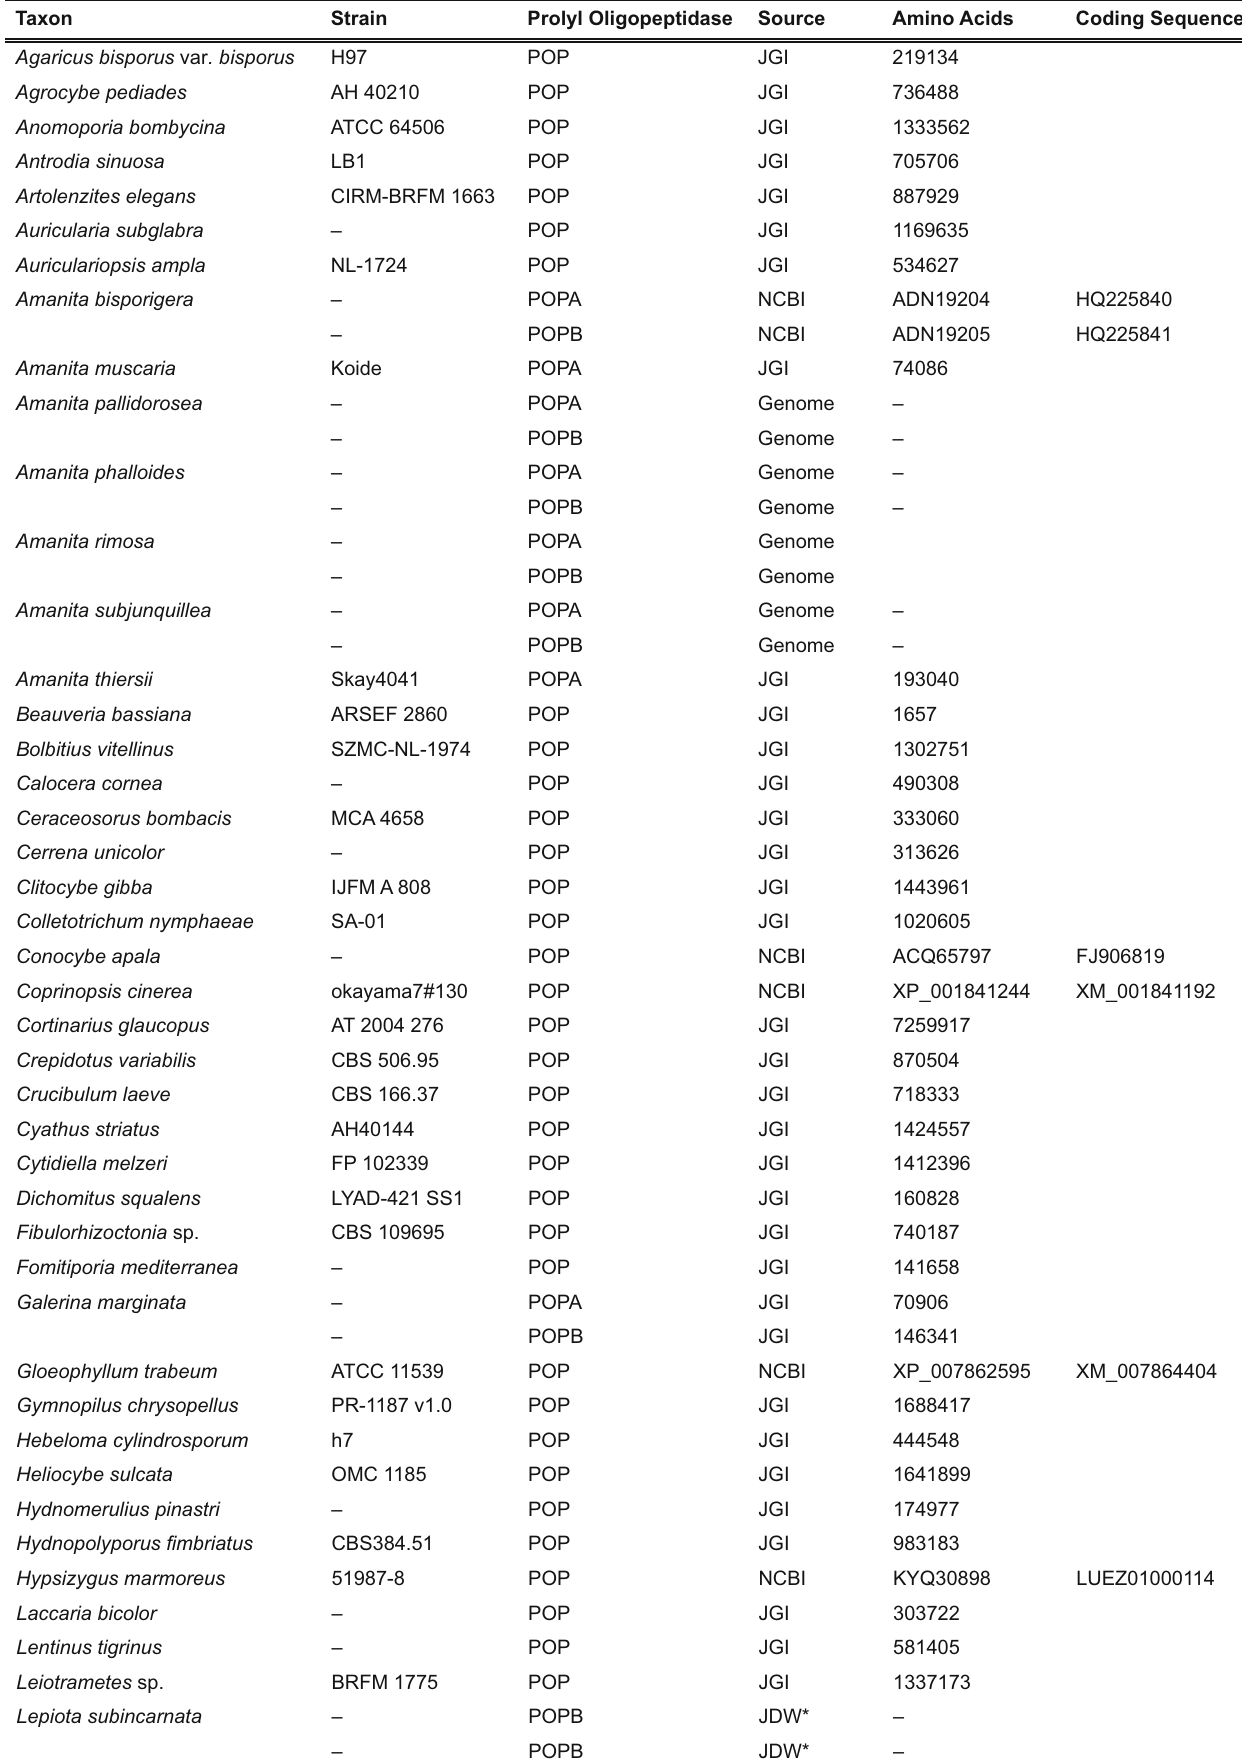
Table 1. Accession numbers of prolyl oligopeptidase gene and amino acid sequences included in the phylogenetic